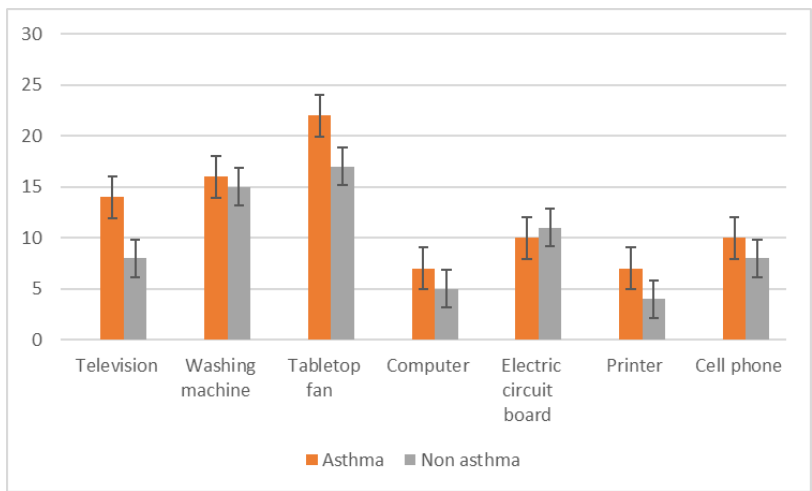
Figure 4. Types of electronic waste items handled by study